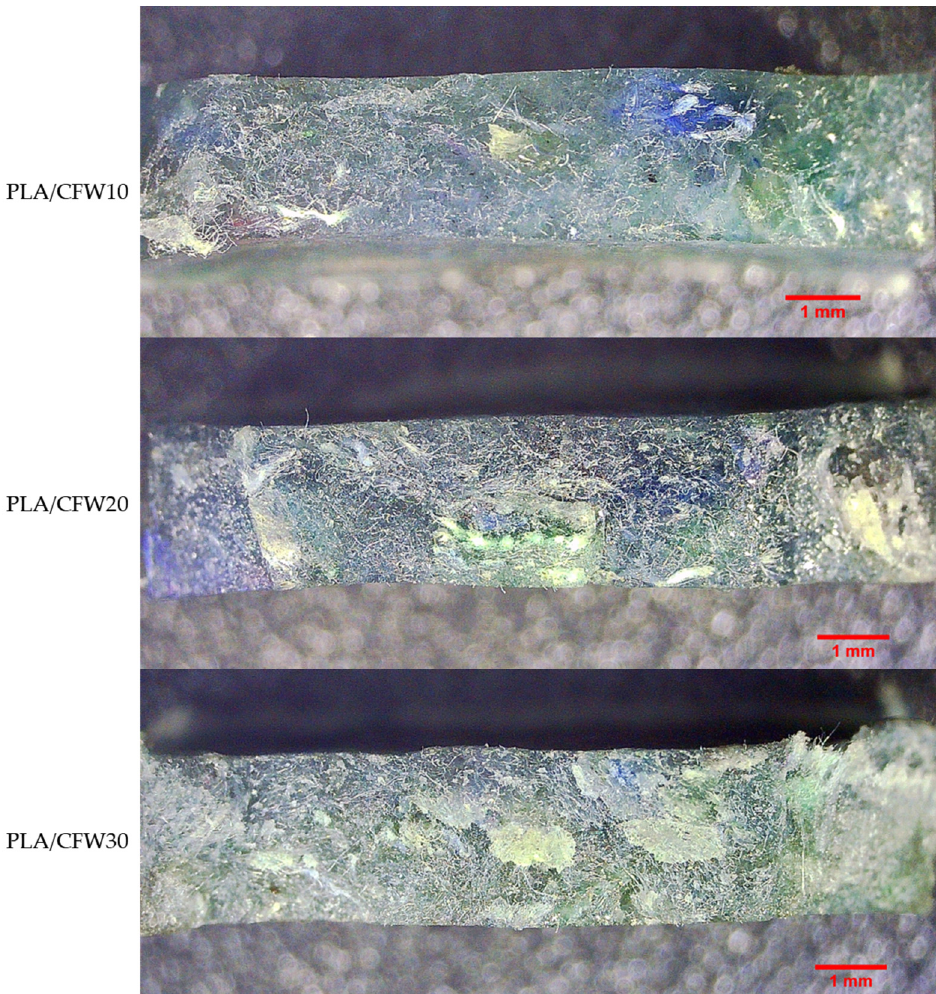
Figure 6. Fiber distribution on the fracture